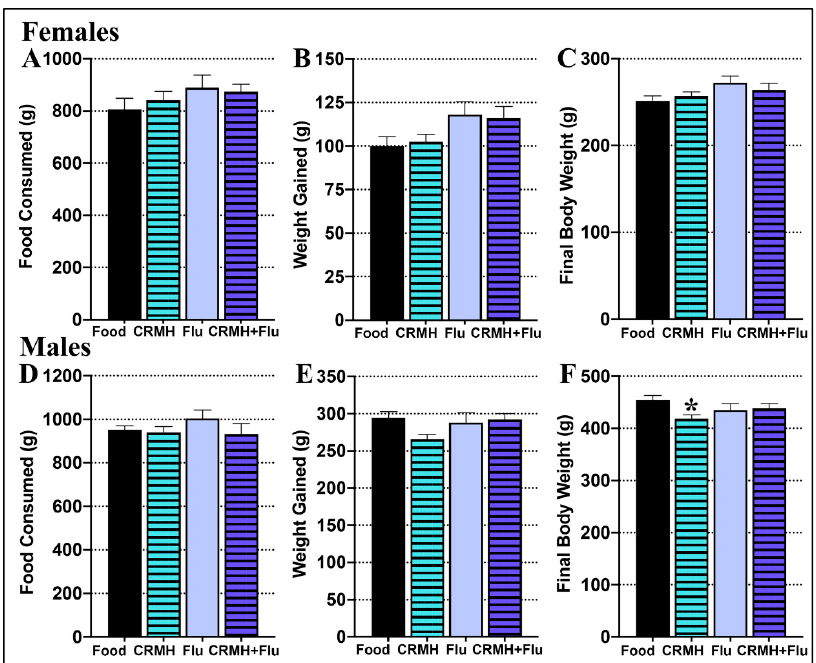
Figure 2. Food consumed, body weight gain and final body weight after 5 weeks of CRMH supple- mentation at altitude. Females in the food control and dietary CRMH groups for the CRDS and CRDS + SSRI studies show no difference in ( A ). food consumed over 5 weeks, ( B ). total weight gained or ( C ). final body weight. Males show no difference between the dietary groups in ( D ).